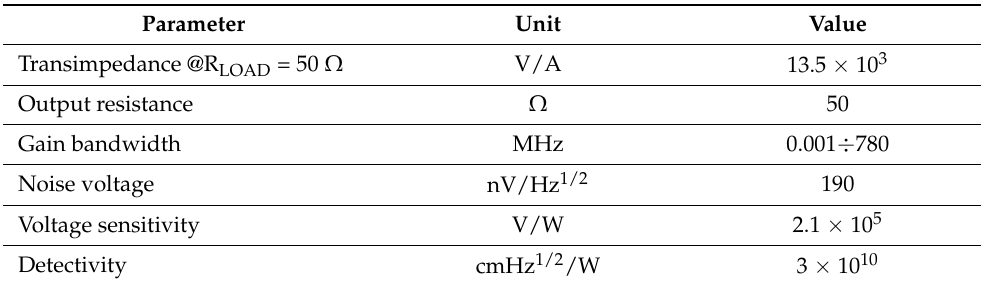
Table 1. The basic parameters of the detection module optimized for a wavelength range of 10 µ m [9].